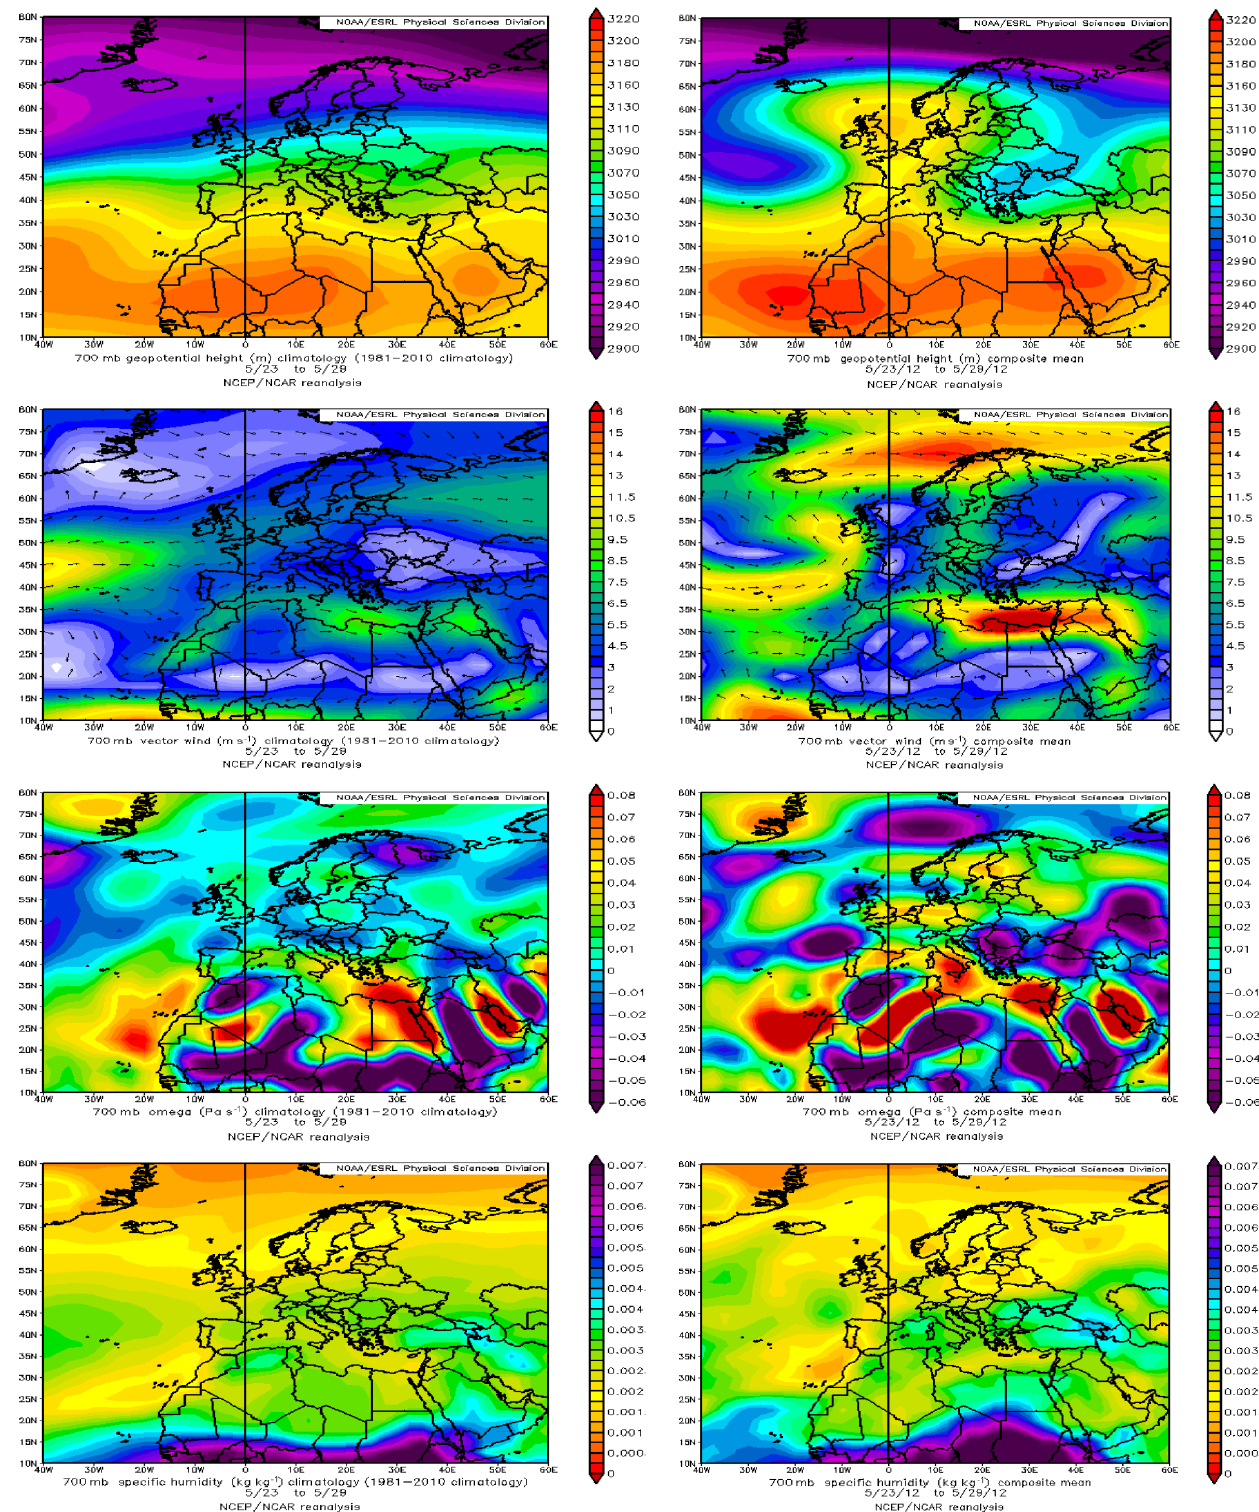
Figure 3. Composite NOAA/ESRL weather maps of geopotential height, vector wind speed, omega vertical velocity and specific humidity for 23–29 May climatology (left column) and for the episode of 23–29 May 2012 at JRC Ispra, Italy (right